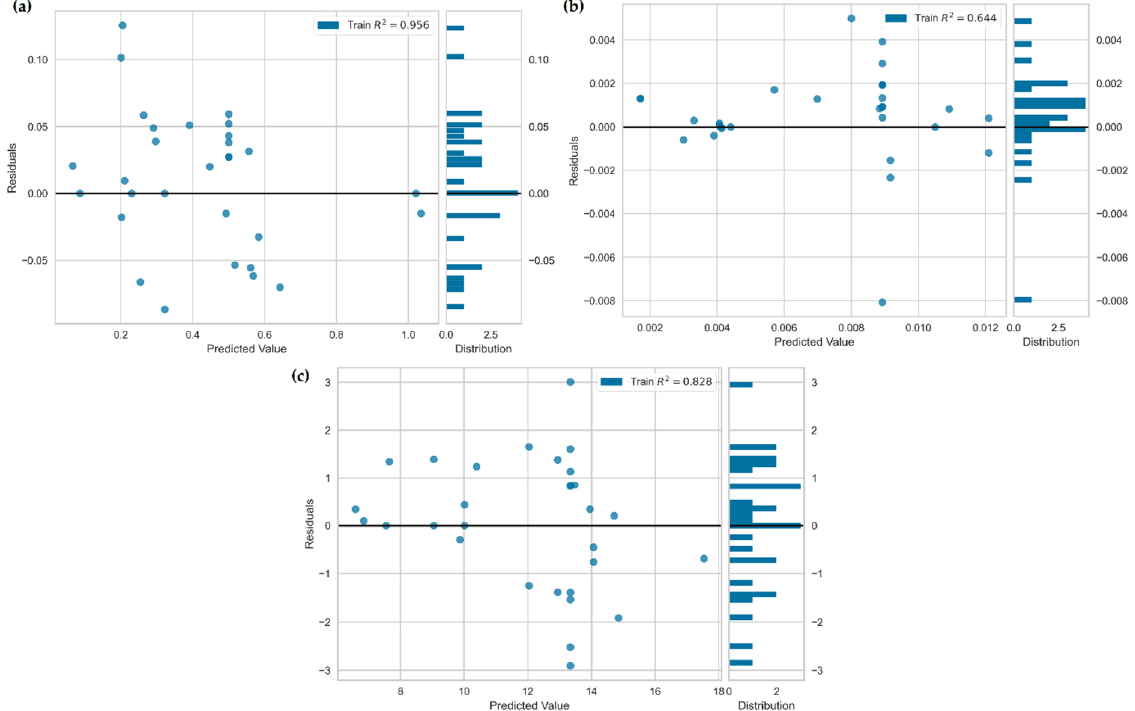
Figure 7. Residuals versus AdaBoost regression predicted ( a ) MRR ( b ) EWR ( c )